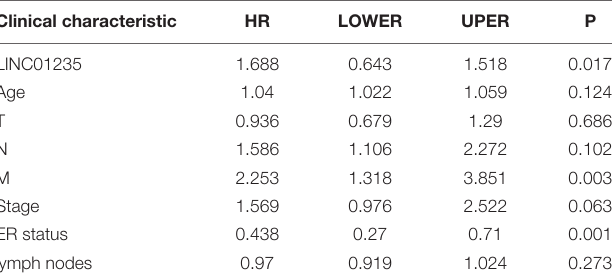
TABLE 8 | Multivariate survival analysis of LINC01235 in breast cancer patients. Clinical